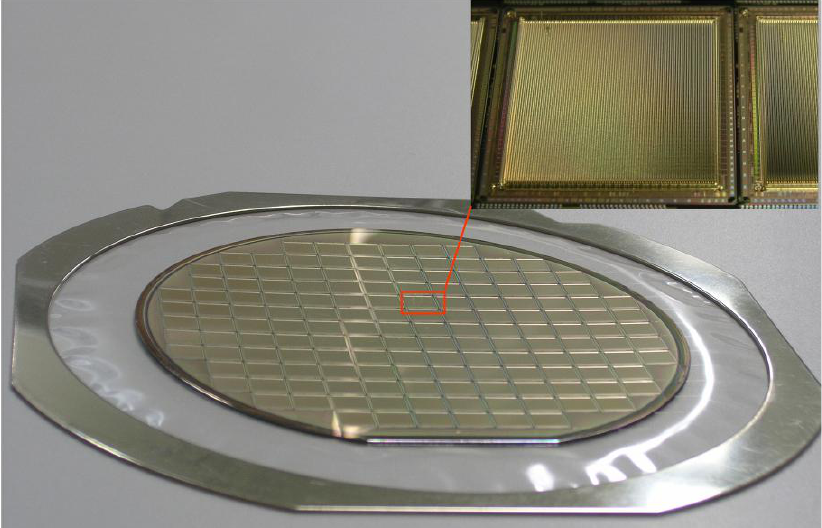
Figure 6. Silicon CMOS wafer with UV molded cylindrical lenslets after dicing. Detail: selective UV curing leaves the bond pads open for electrical